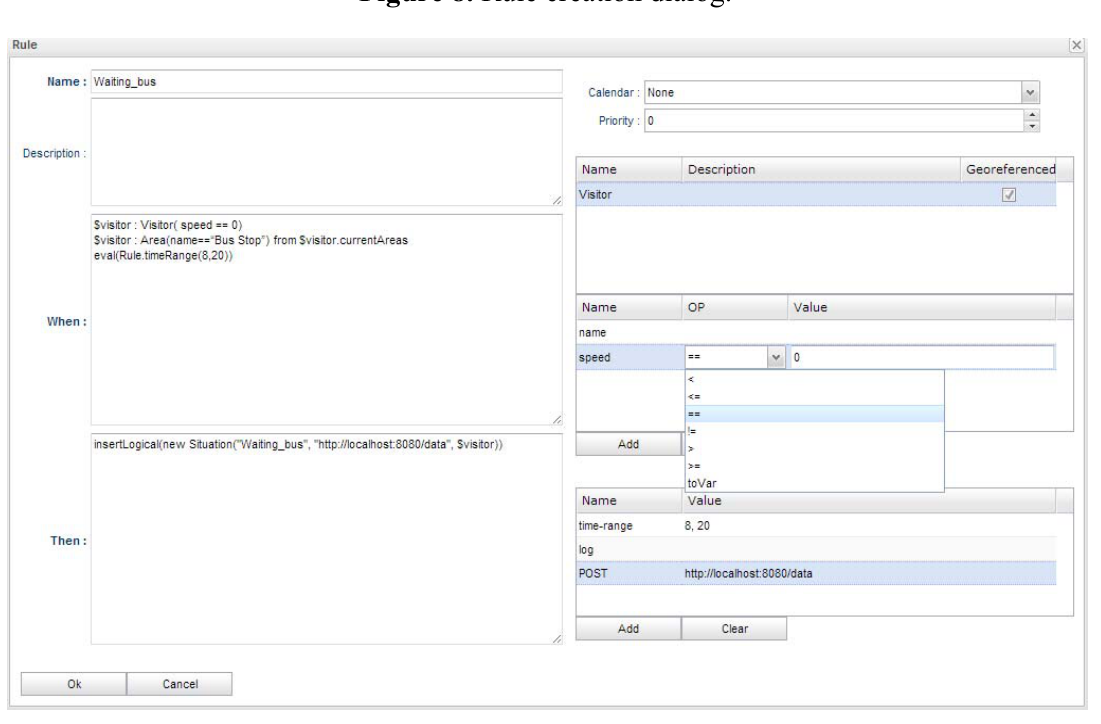
Figure 8. Rule creation